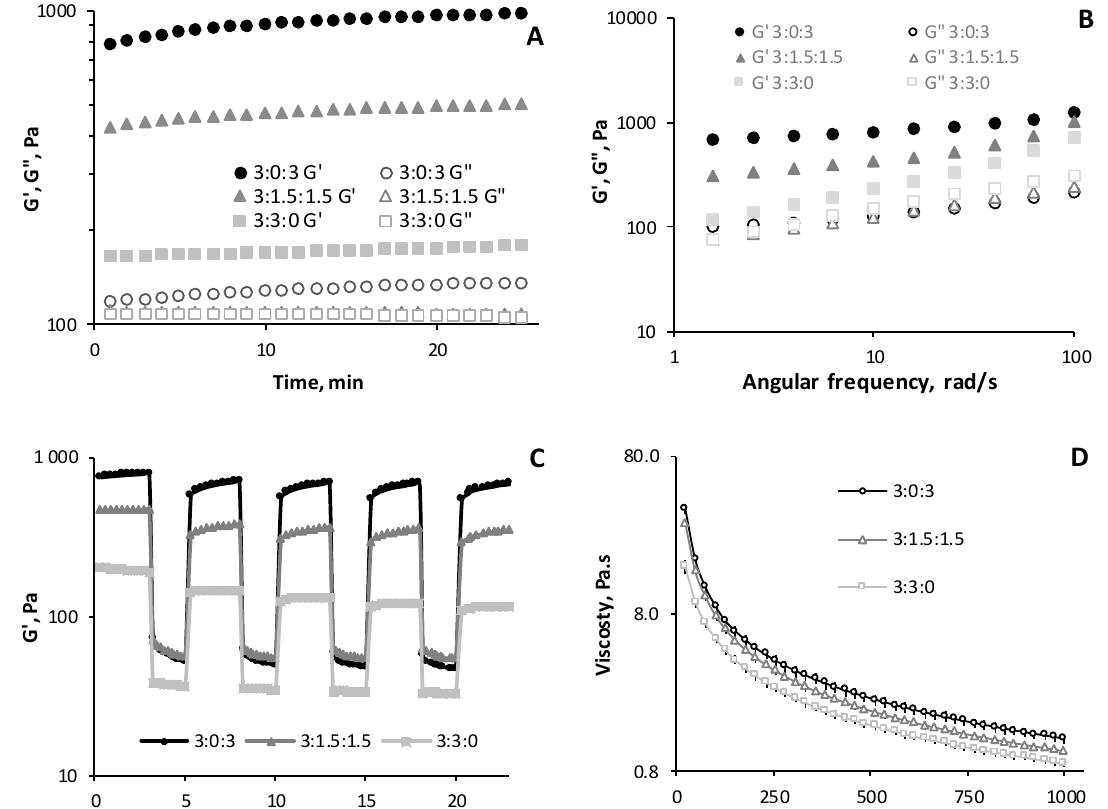
Figure 5. Rheological analysis of the hydrogels at different CHT:PCDi:PCDs ratios: ( A ) Evolution of the storage (G ′ ) and loss (G ′′ ) modulus as a function of time at a frequency of 1 Hz at 37 °C (the G ′′ curve of hydrogel 3:1.5:1.5 is overlapped by the G ′′ curve of hydrogel 3:3:0). ( B ) the frequency sweep determining G ′ and G ′′ at a constant strain of 1%. ( C ) The self-healing evaluation by cyclic step–strain measurements at a low strain of 1% and at a high strain of 500% at 1 Hz of frequency at RT, and ( D ) the shear-thinning evaluation by shear-rate dependent variations of viscosity at RT. Average values obtained from three different measurements are represented in all graphs.